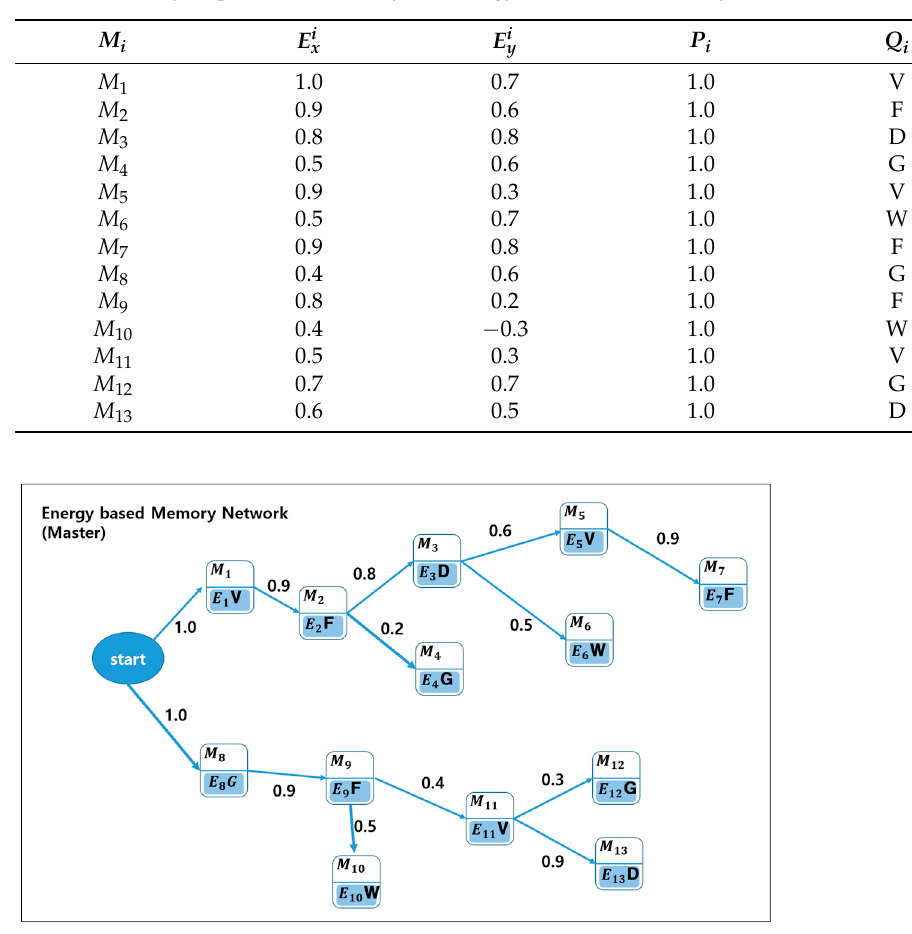
Table 2. Memory Capsule list: Memory ID, Energy value, P i (Probability of Self), Q i (Qualia).